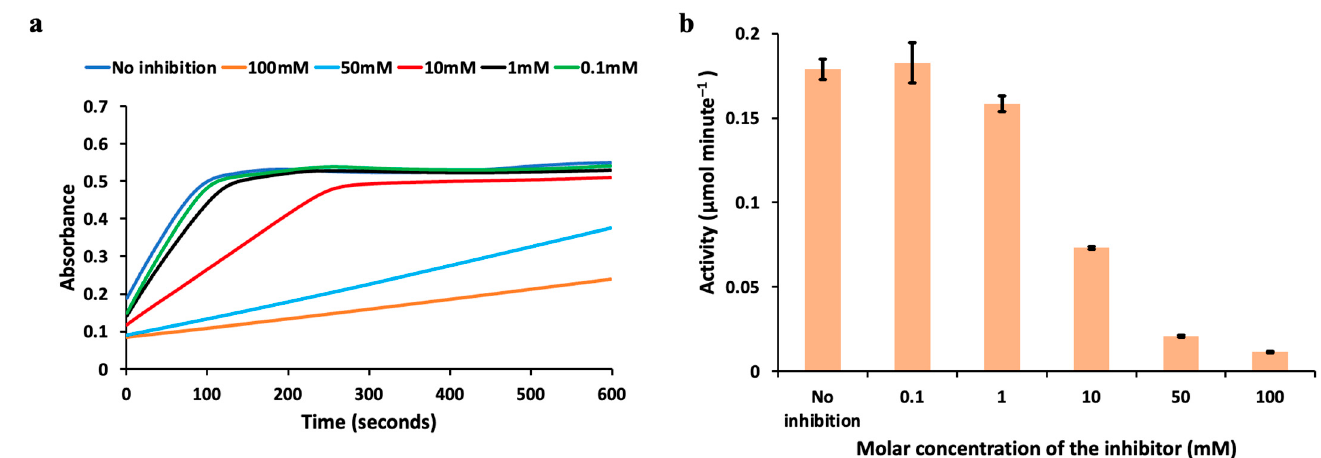
Figure 6. The effect of the molar concentration of the inhibitor on the enzyme kinetics at reaction Rate1 is shown in this figure. ( a ) Enzyme kinetics monitored over time at Rate1 under the influence of the inhibitor at different molar concentrations. ( b ) Activity calculated with and without an inhibitor (at different molar concentrations) for the fixed volume concentration is shown with error bars.